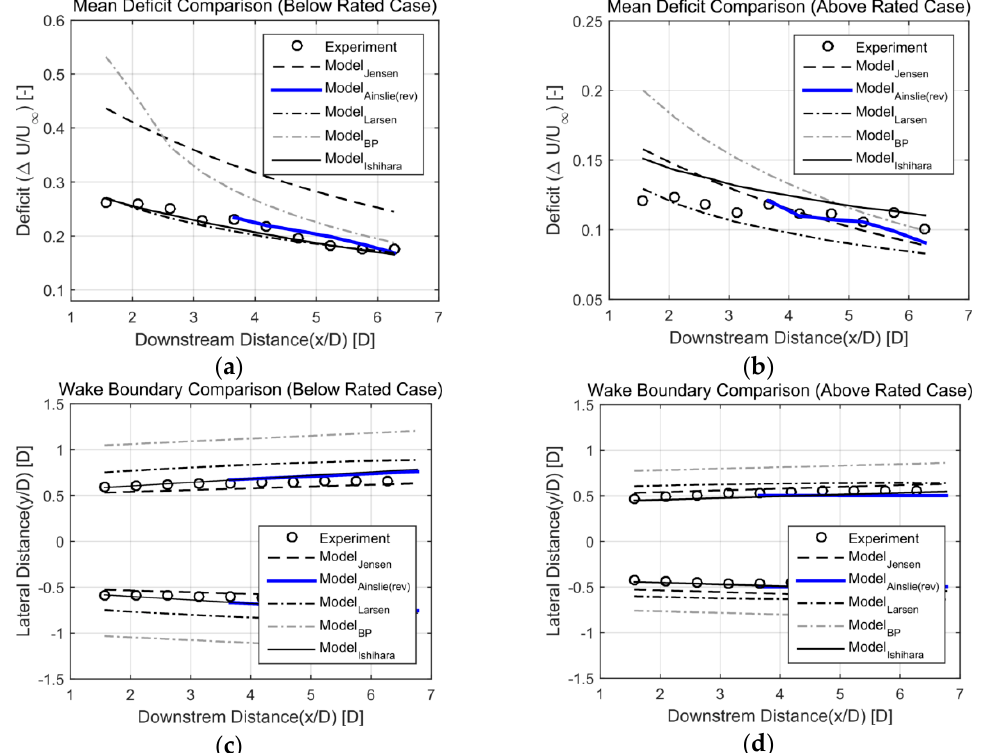
Figure 8. The comparison of each wake model includes modified Ainslie eddy viscosity wake model; ( a ) deficit variations in below rated case; ( b ) deficit variations in above rated case; ( c ) comparison of wake boundary layers in below rated case; ( d ) comparison of wake boundary layers in above rated case.